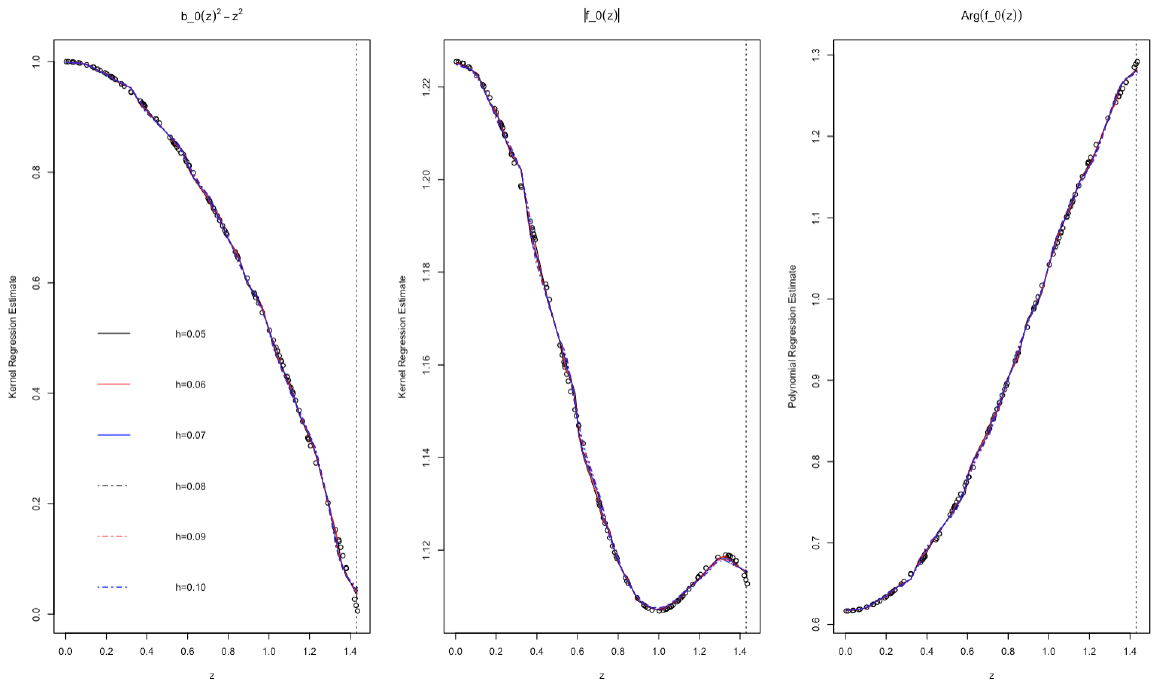
Figure 6. The estimates of critical collapse functions corresponding to an α solution of a hyperbolic case based on a kernel regression method with bandwidth parameters h = { 0.05,0.06,0.07,0.08,0.09,0.10 } based on a training sample of size n =